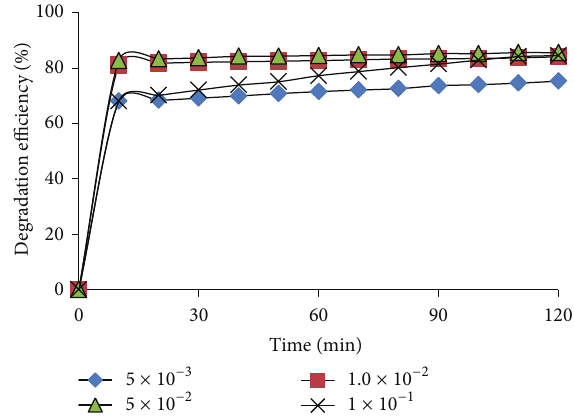
Figure 4: Effect of H 2 O 2 concentration on the discoloration efficiency for Fenton-like oxidation process ([MAG] = 3.0 × 10 −5 M, [Fe +3 ] = 1.0 × 10 −4